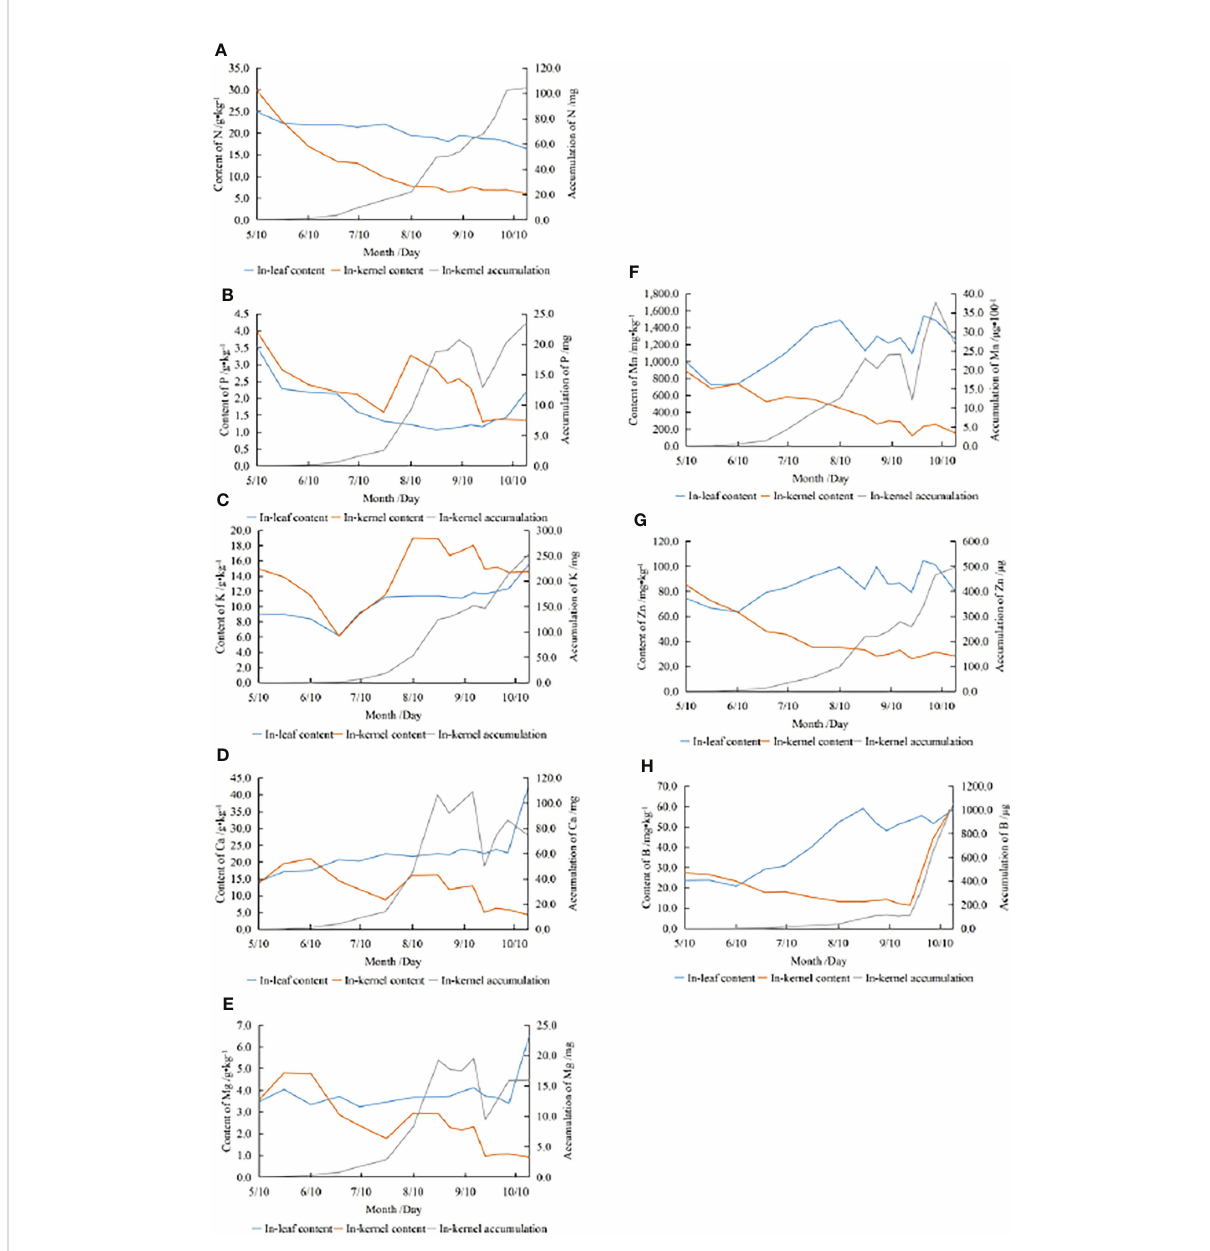
FIGURE 2 Dynamics of the concentrations and accumulation of N (A) , P (B) , K (C) , Ca (D) , Mg (E) , Mn (F) , Zn (G) , B (H)